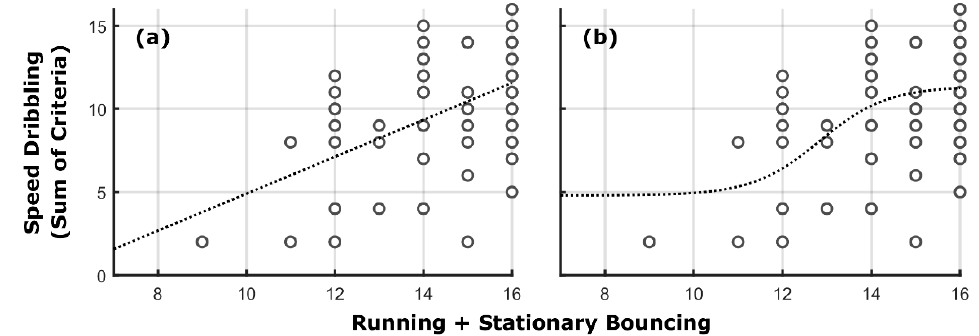
Figure 1. Relation between the sum of stationary dribbling and running components and speed